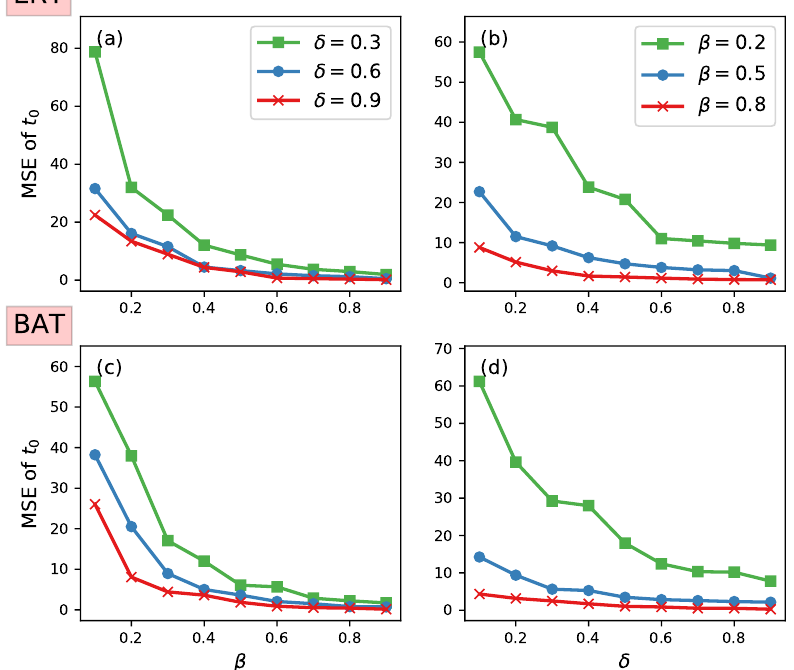
Figure 5. MSE of initial time in tree network. ( a , c ) represent the relationship between MSE of t 0 and β under various δ = 0.3,0.6,0.9 in ERT and BAT respectively. ( b , d ) represent the relationship between MSE of t 0 and δ under various β = 0.2,0.5,0.8 in ERT and BAT respectively. The ordinate in the figure represents the mean square error of the initial time t 0 . The lower the mean square error is, the more accurate the estimation of PESL becomes. In all experiments, the number of observers was K = 10 and the recovery probability in the SIR model was γ =